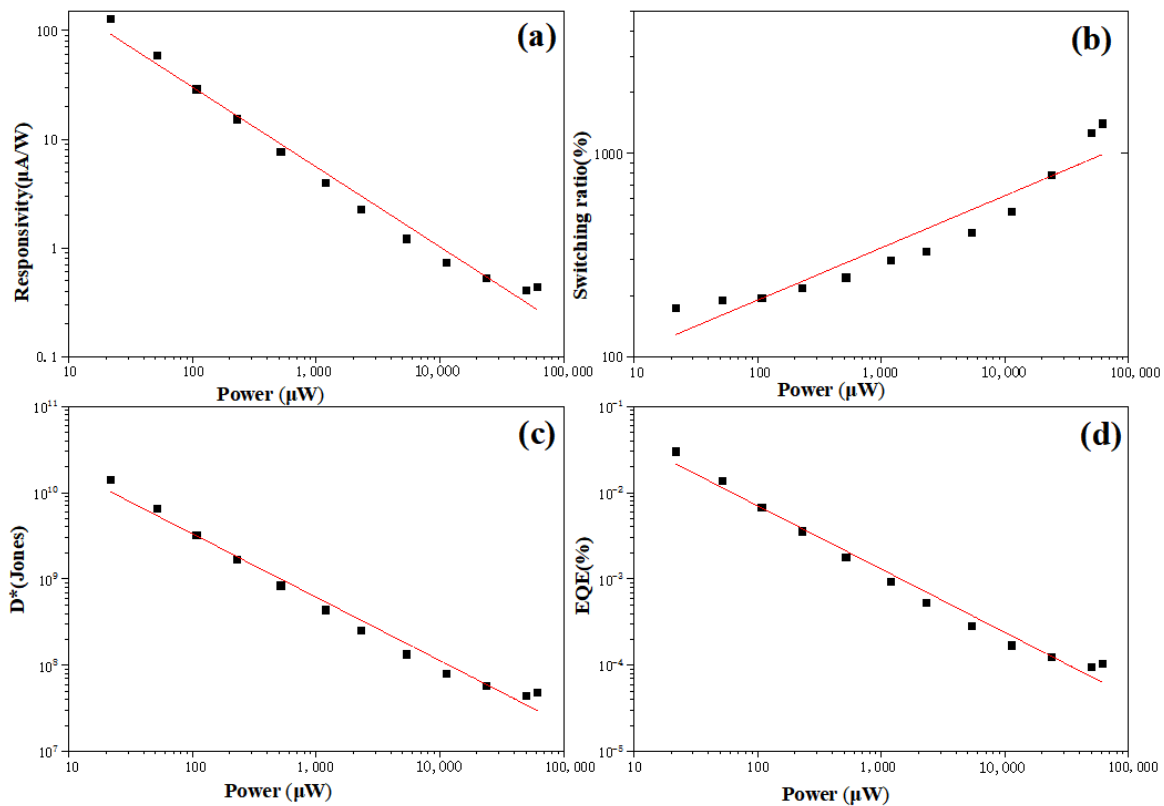
Figure 6. Fitting photoresponse characteristics of HDA-BiI 5 -based photodetectors under 532 nm laser: ( a ) photoresponsivity, ( b ) switching ratio, ( c ) specific detectivity, ( d ) External quantum efficiency.